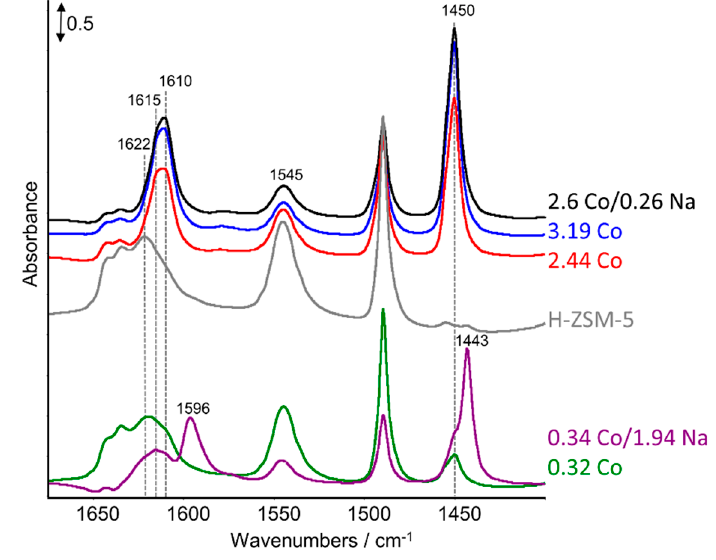
Figure 2. Pyridine adsorbate spectra measured at 150 °C.